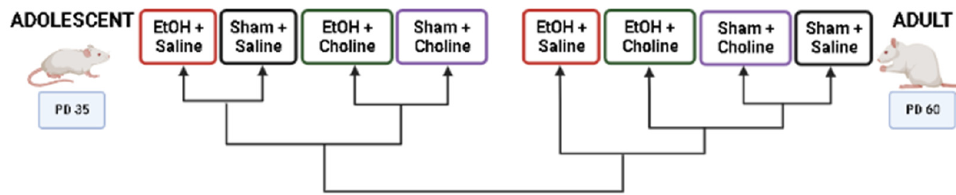
Figure 2. Hippocampal cytokine profiles during adolescence and adulthood. Overall, analysis demonstrates a noticeable clustering of cytokines patterns by age. Rows represent groups, as indi- cated, and the columns represent mean cytokine levels ( z -scored data) for each group. Colors demonstrate deviations from the mean of zero, as indicated in the color key. EtOH: Ethanol.